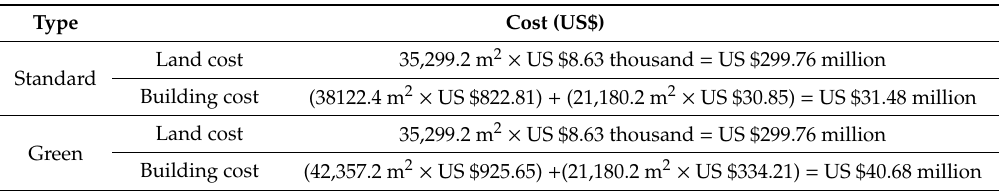
Table 1. Comparison table. Cost of urban renewal, standard building vs. green infrastructure